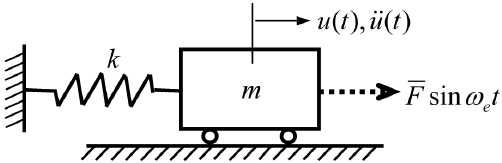
Fig. 2. A SDOF spring-mass system subjected to a harmonic force ¯ F sin ω e t